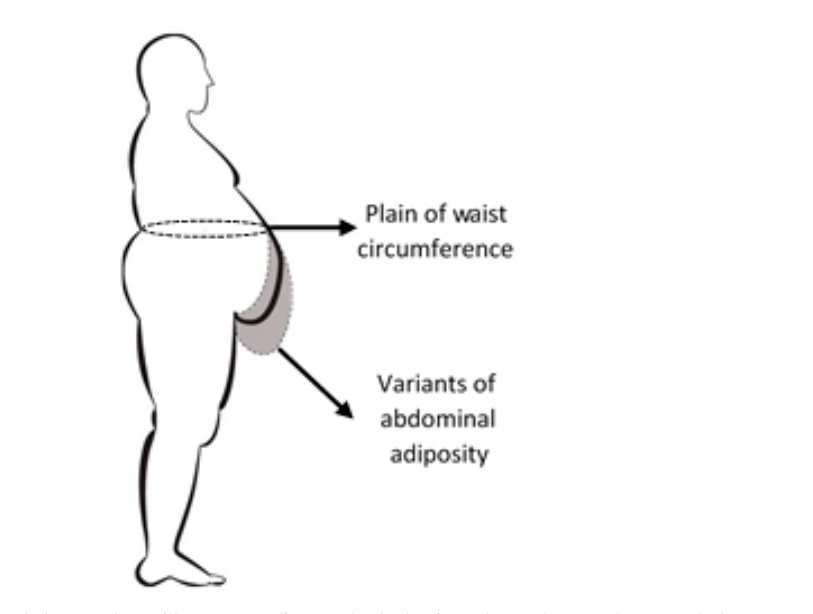
Figure 1. Thoracic-abdominal profile in case of non-alcoholic fatty liver disease (NAFLD) Figure 1. Thoracic ‐ abdominal profile in case of non ‐ alcoholic fatty liver disease (NAFLD) diagnosis.